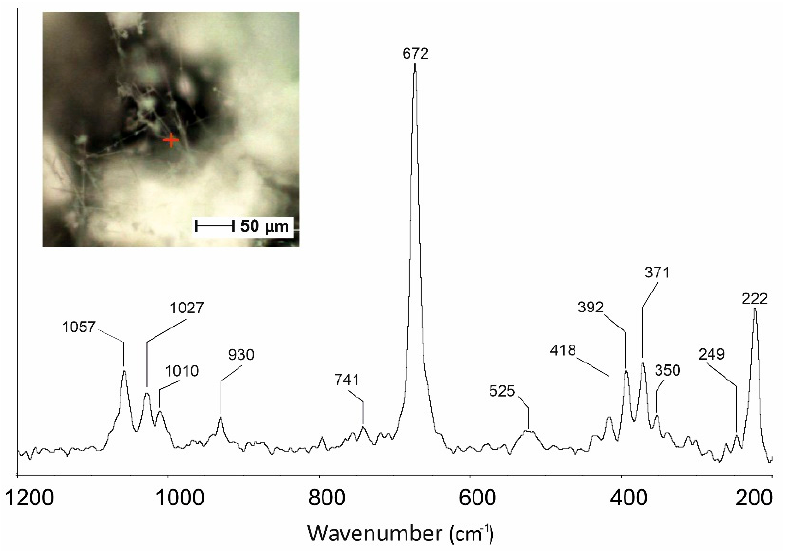
Figure 10. Micro-Raman spectrum of the Ni-doped tremolite run TN8 (800 °C, 2.4 kbar, 16 days). The bands in the spectral region ranging from 300 to 200 cm − 1 are produced by O-H-O motifs [17]. In this region, two bands are detected, at 249 and 222 cm − 1 . When the spectrum of TN8 fibers is compared with the Raman spectrum from pure synthetic tremolite [23],